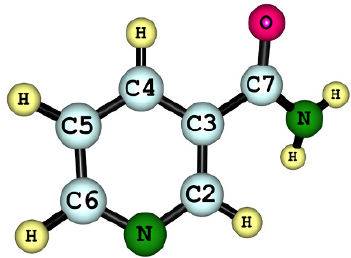
Figure 1. Structural formula of nicotinamide with atomic numeration. Table 1. Stability constants of mono (K complex of nickel(II) ion in aqueous dimethyl sulfoxide. , m.f. X DMSO